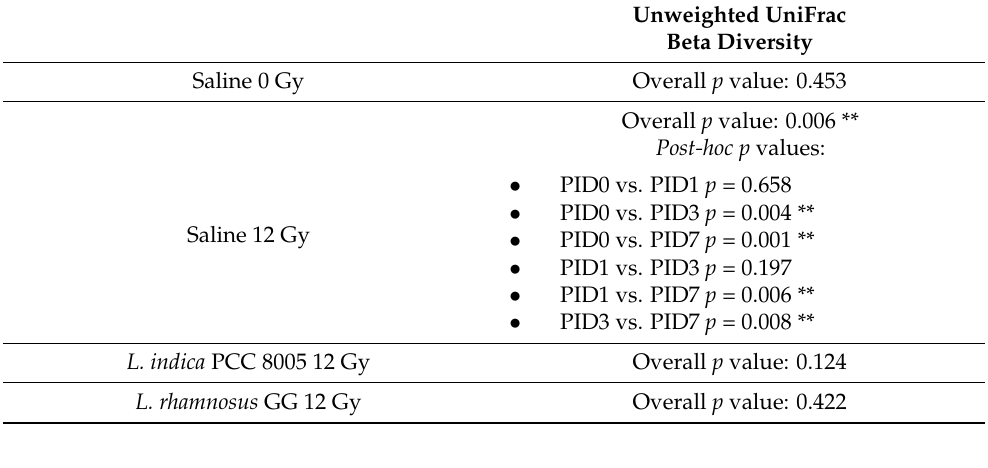
time (Table 1 and Figure 9). Table 1. p values (** p <0.01) of paired unweighted UniFrac beta diversity analyses by AMOVA. PID = post-irradiation day.